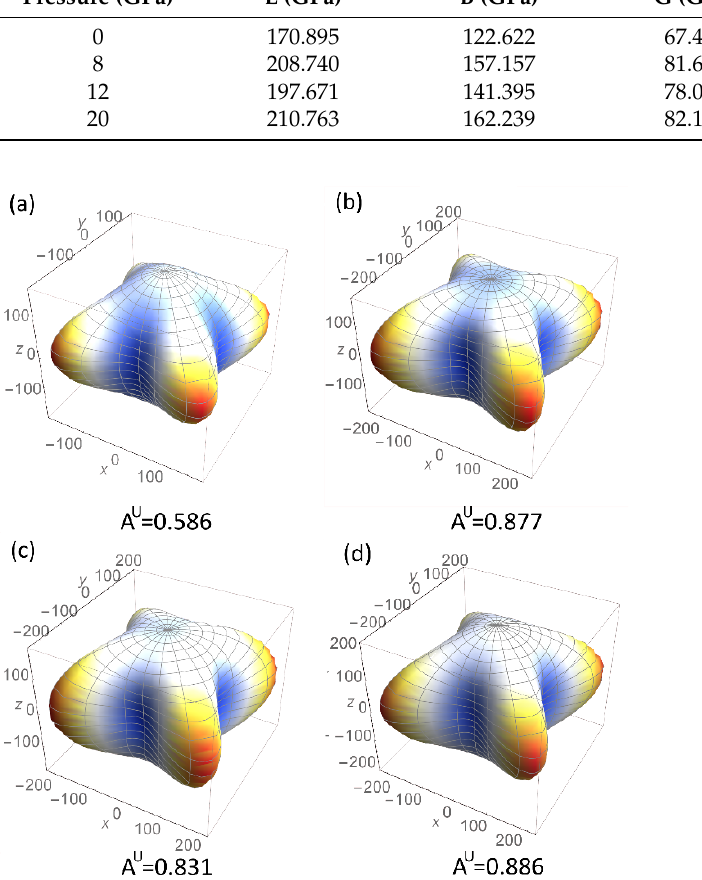
Figure 10. 3D Young’s modulus (E) of U 3 Si 2 C 2 (unit: GPa) with external pressure of ( a ) 0 GPa, ( b ) 8 GPa, ( c ) 12 GPa, and ( d ) 20 GPa. The anisotropic index A U are presented.